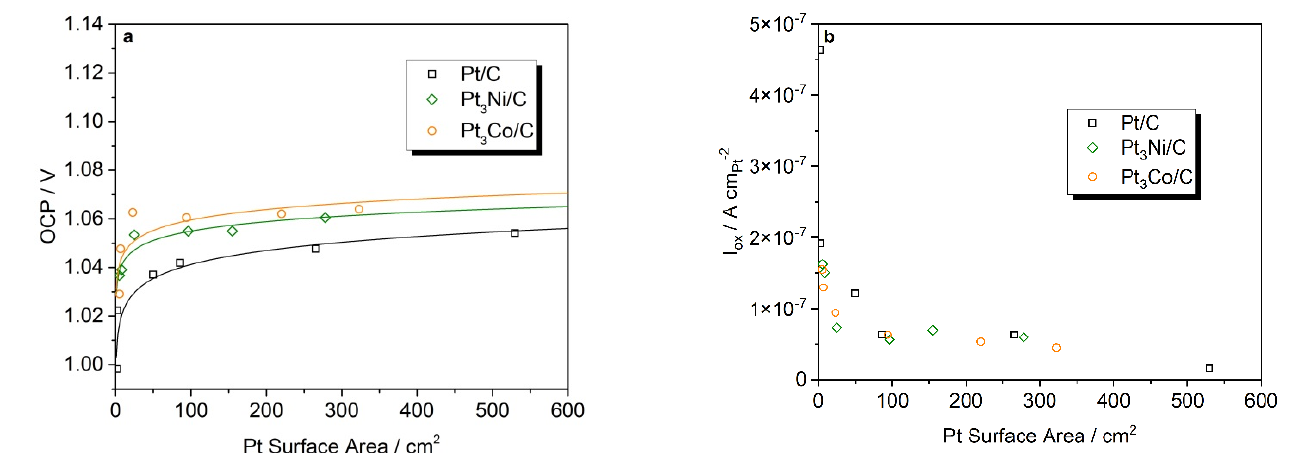
Figure 5. ( a ) The dependency of OCP on Pt surface area measured on Pt/C, Pt 3 Ni/C and Pt 3 Co/C GDEs of various loadings ex situ in 0.1 M HClO 4(aq) electrolyte at 30 °C. ( b ) Calculated oxidative current normalised to Pt surface area vs. Pt surface area.